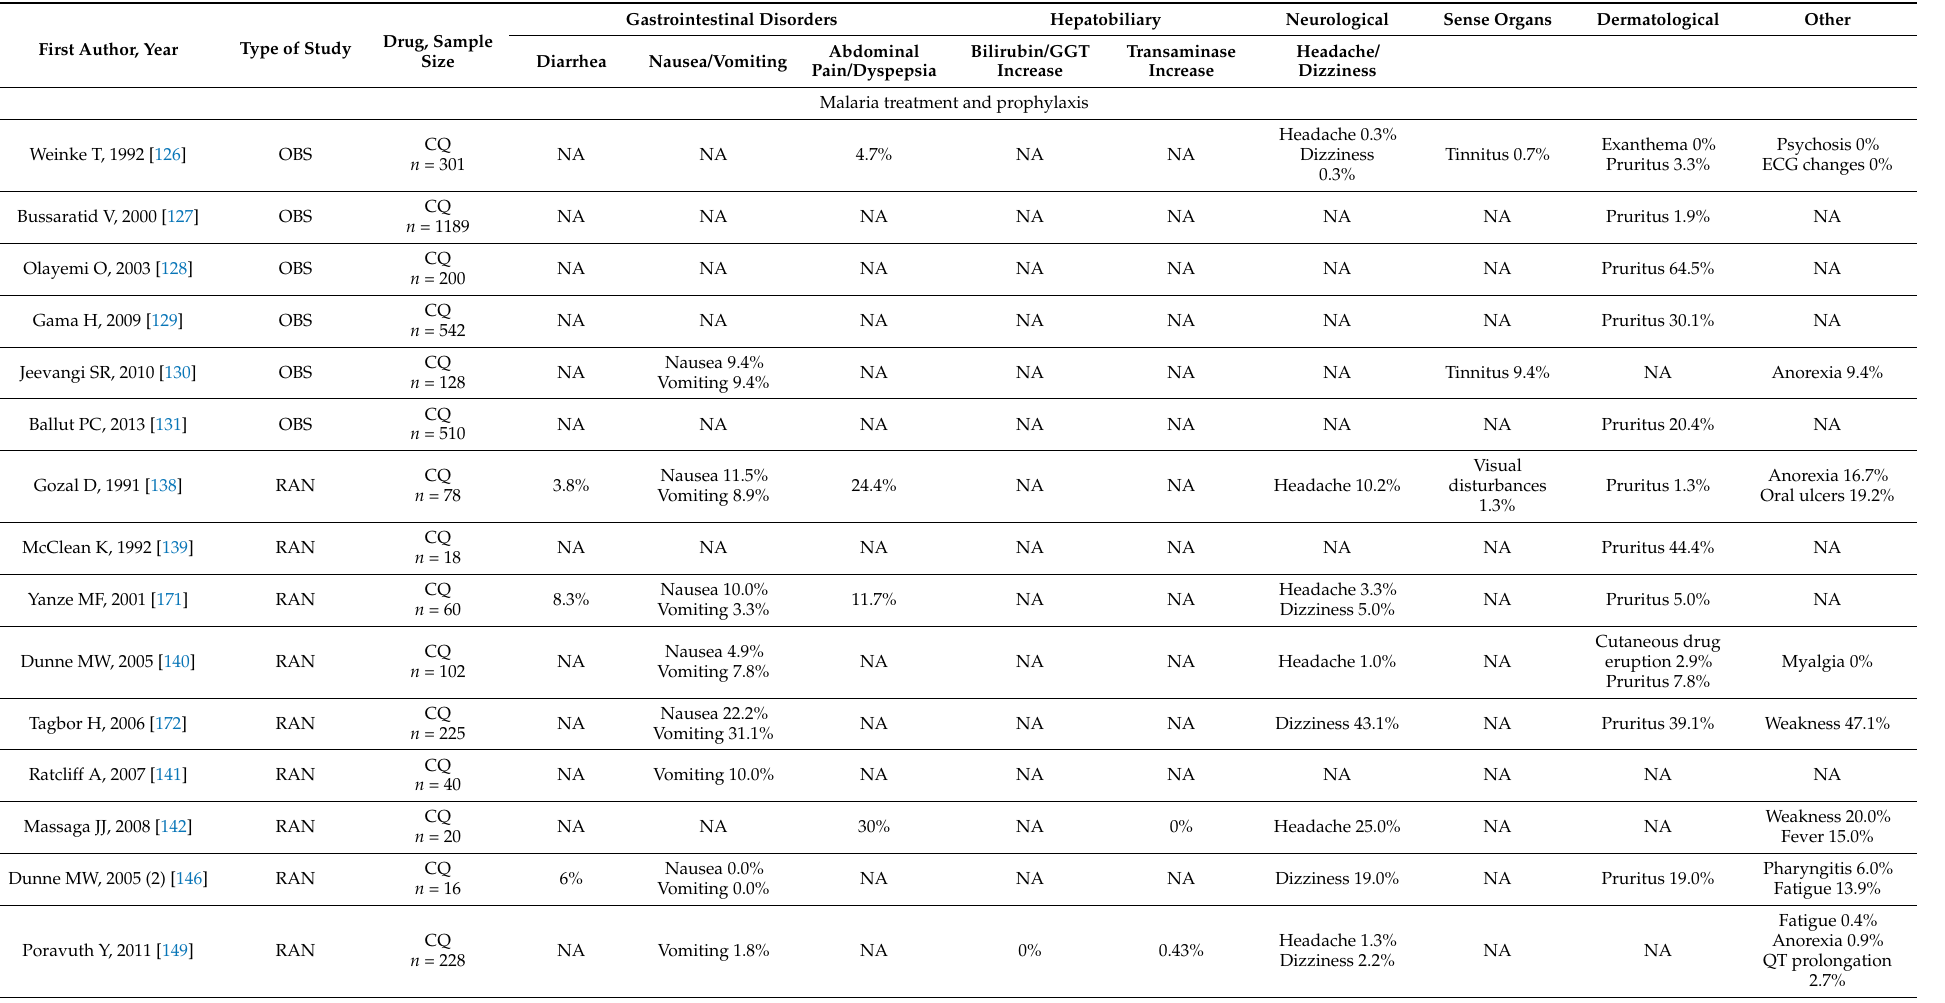
Table 3. Summary of included studies reporting data on the frequency of early adverse events of CQ or HCQ alone (except